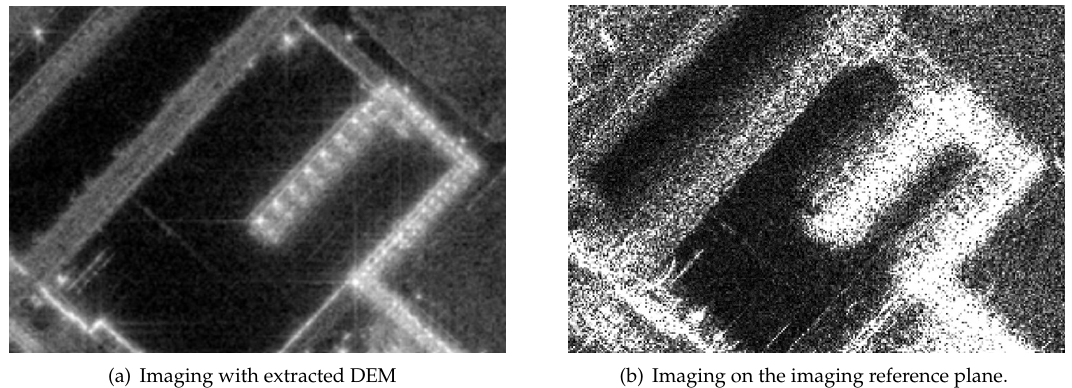
(a) Imaging with extracted DEM (b) Imaging on the imaging reference plane. Figure 19. Region B: All-aperture image formed via magnitude accumulation of all the sub-aperture